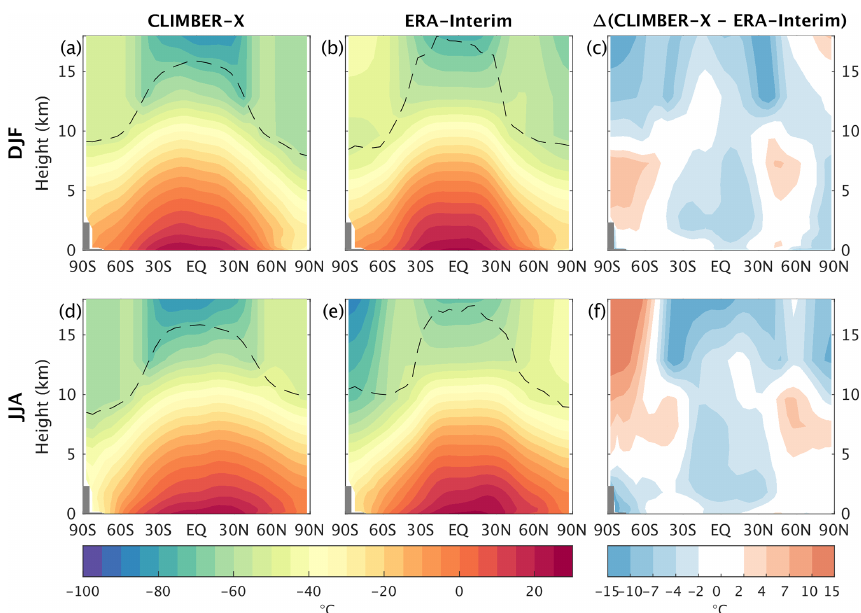
Figure 6. Zonal mean temperature simulated by CLIMBER-X for (a) DJF and (d) JJA compared to ERA-Interim reanalysis (Dee et al., 2011) (b, e) . The temperature bias relative to ERA-Interim is shown in panels (c) and (f) . The dashed black line indicates the height of the